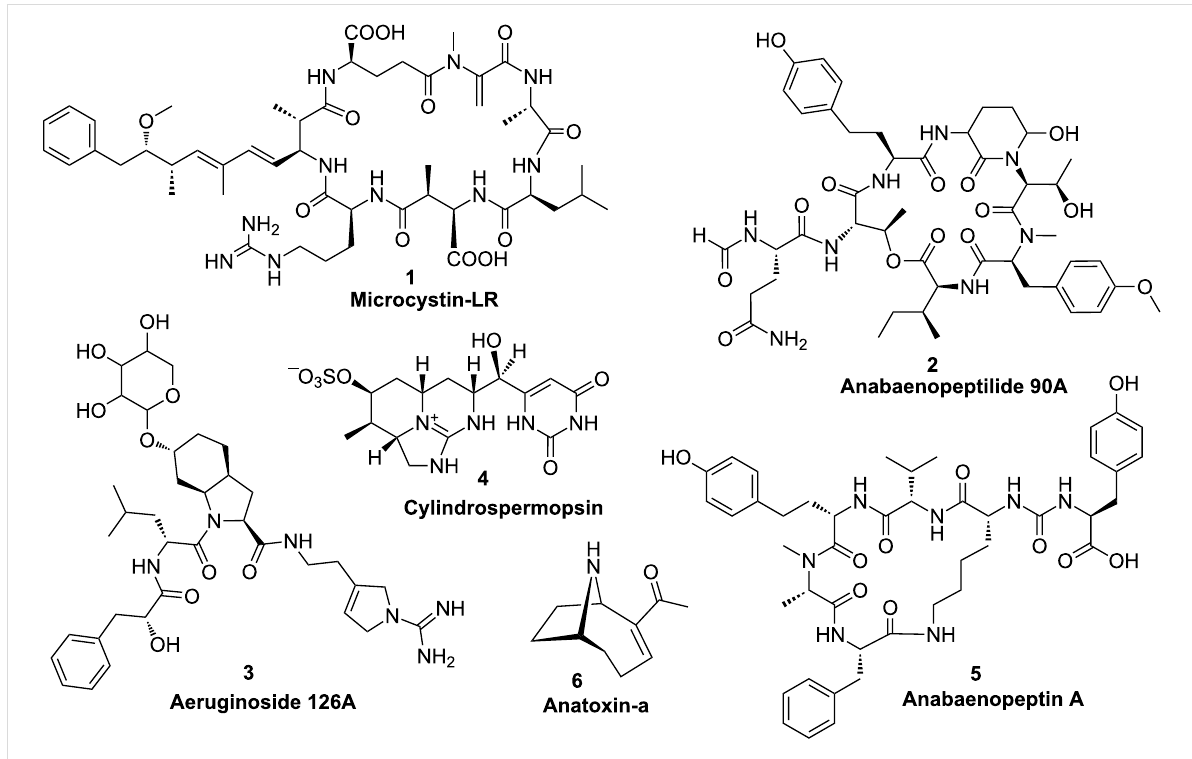
Figure 3: Structures of NRPS and PKS products in freshwater